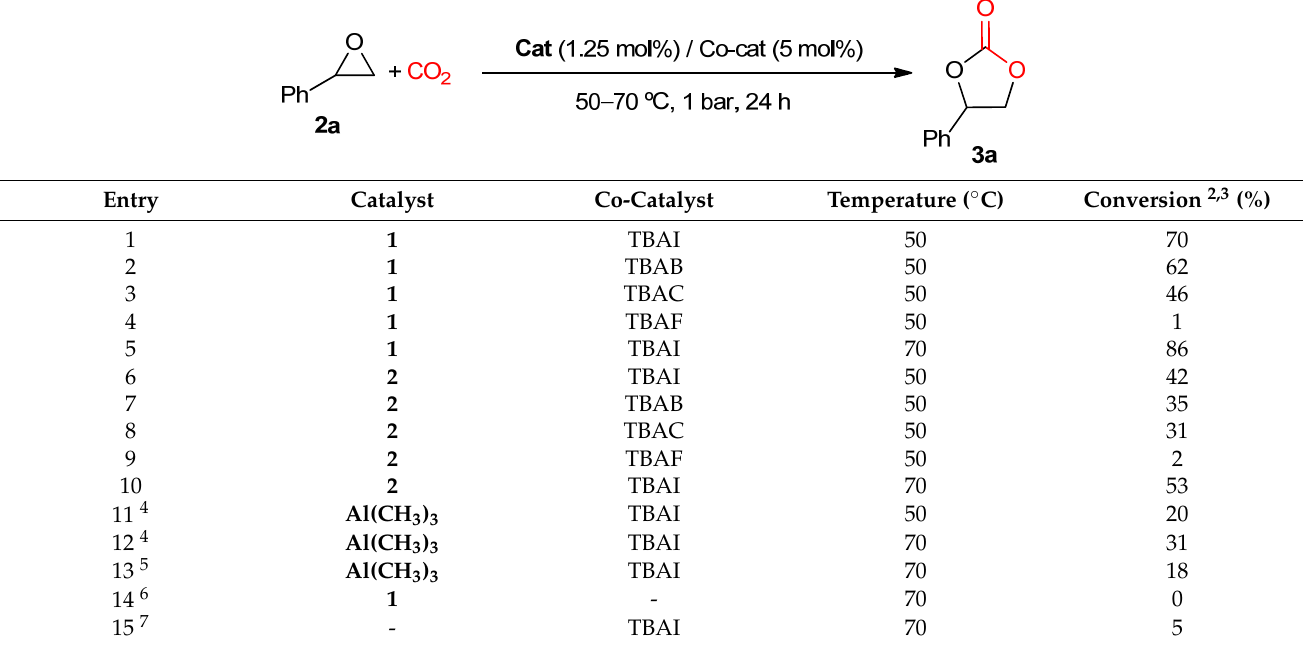
Table 1. Optimization of reaction conditions for the preparation of styrene carbonate ( 3a ).